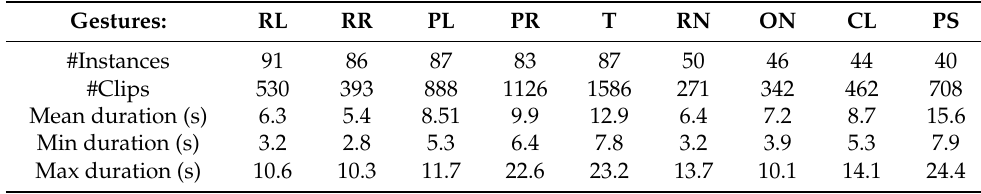
Table 2. Overview of the surgical gesture